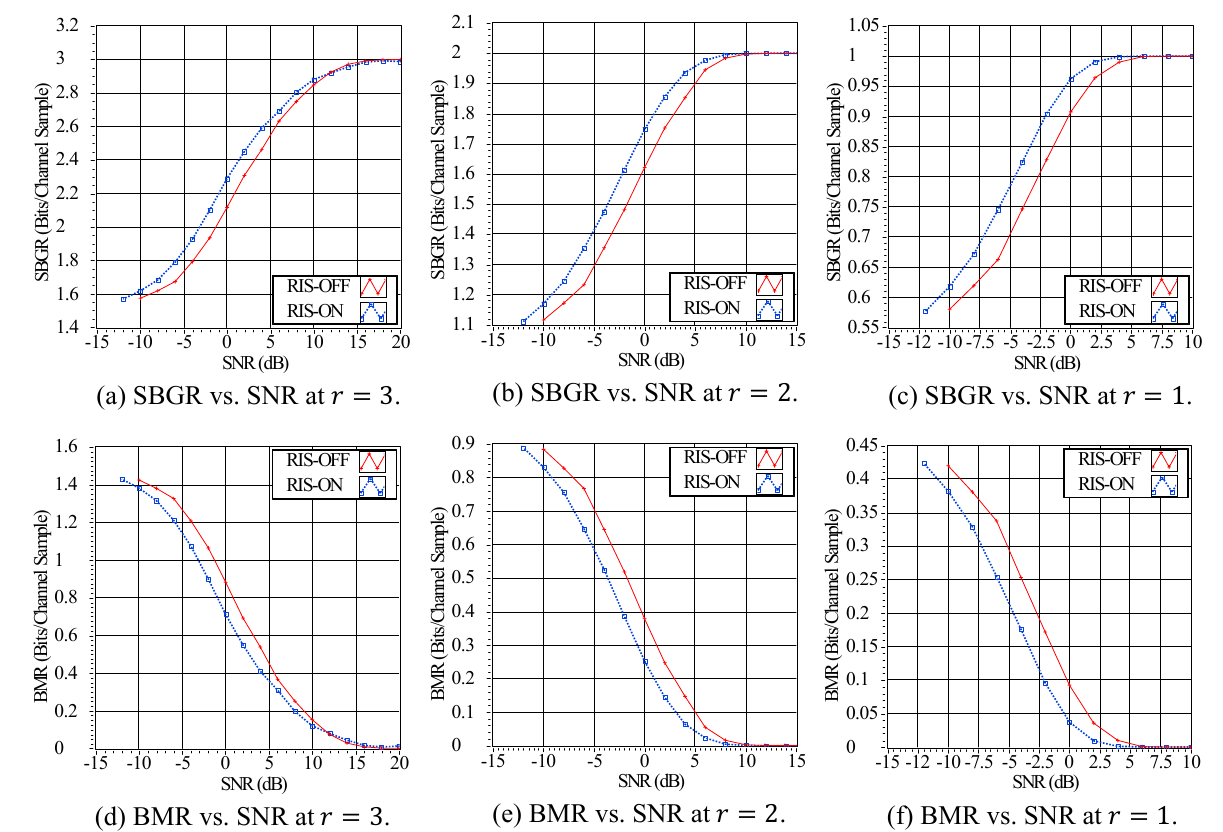
Figure 7. The scheme’s performance of the SBGR and the BMR at different SNRs and r = { 1,2,3 } .